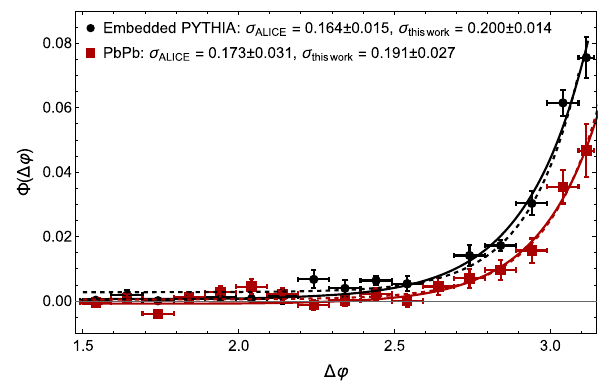
Fig. 17 The (cid:15)((cid:7)ϕ) distributions for 0-10% centrality Pb-Pb colli- sions (red) measured by the ALICE collaboration [71] and PYTHIA- simulated pp collisions embedded into central Pb-Pb collisions (black), √ s NN = 2 . 76 TeV. The error bars indicate statistical errors only. at Both datasets are fit to exponential functions of the form shown in (77); this work fits over the whole (cid:7)ϕ range (solid lines), while the ALICE collaboration fitted over 2 π/ 3 < (cid:7)ϕ < π (dashed lines). Both sets of fits are shown by the lower red (Pb-Pb) and upper black (pp)